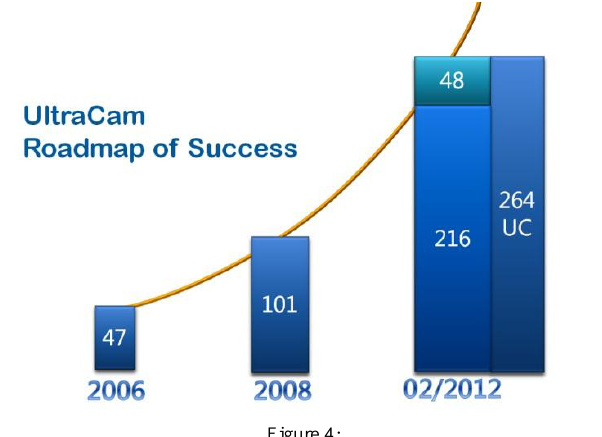
Figure 4: Global UltraCam installations. The column for 2011 differentiates